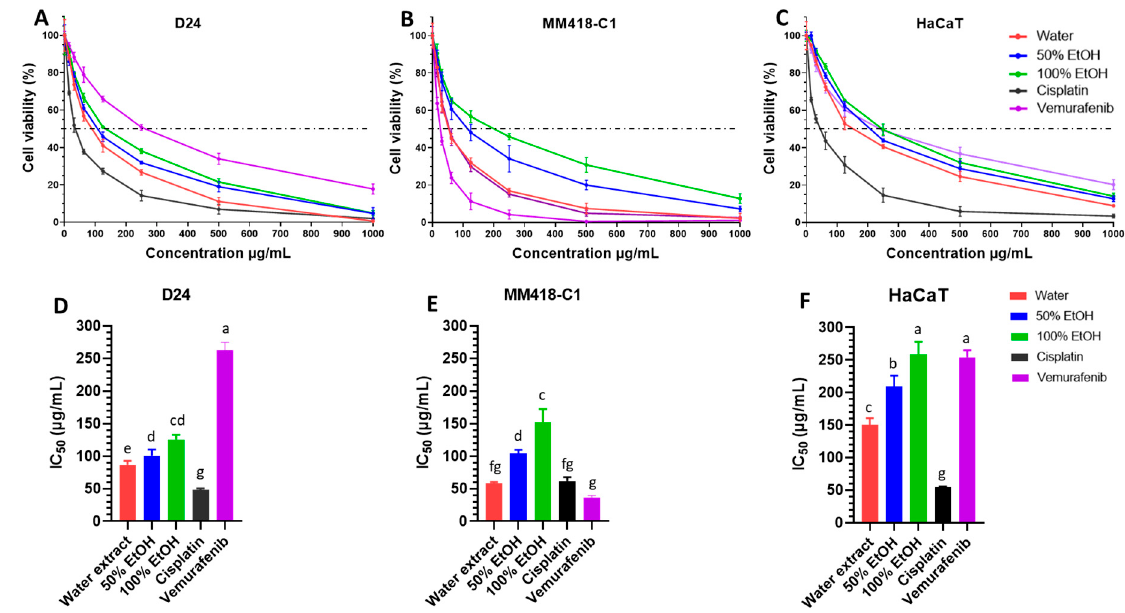
Figure 1. Effect of M. cochinchinensis seed extracts on the cell viability and half inhibition concentration (IC50) of D24 and MM418-C1 melanoma and HaCaT cells ( n = 3). Dose response of cells (% viability) after 48 h treatment with different concentrations of water, 50% EtOH and 100% EtOH extracts, cisplatin and vemurafenib on D24 melanoma cells ( A ), MM418-C1 melanoma cells ( B ), and HaCaT cells ( C ). Cell viability (%) was expressed as the average ratio of the treated divided by the untreated control (the dotted lines represented 50% cell viability); half inhibition concentration (IC50) of the seed extracts for D24 melanoma cells ( D ), MM418-C1 melanoma cells ( E ), and HaCaT cells ( F ). The results were presented as the mean ± SEM, different letters indicated statistical significance at p ≤ 0.05 between different treatments (Analysis by One-way ANOVA with Turkey’s LSD test).